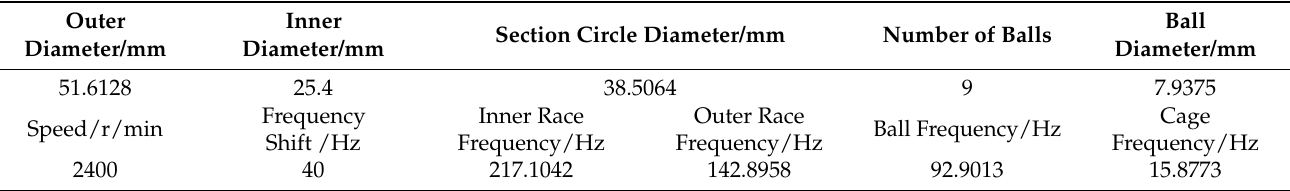
Table 7. Test parameters for 13 different fault states.